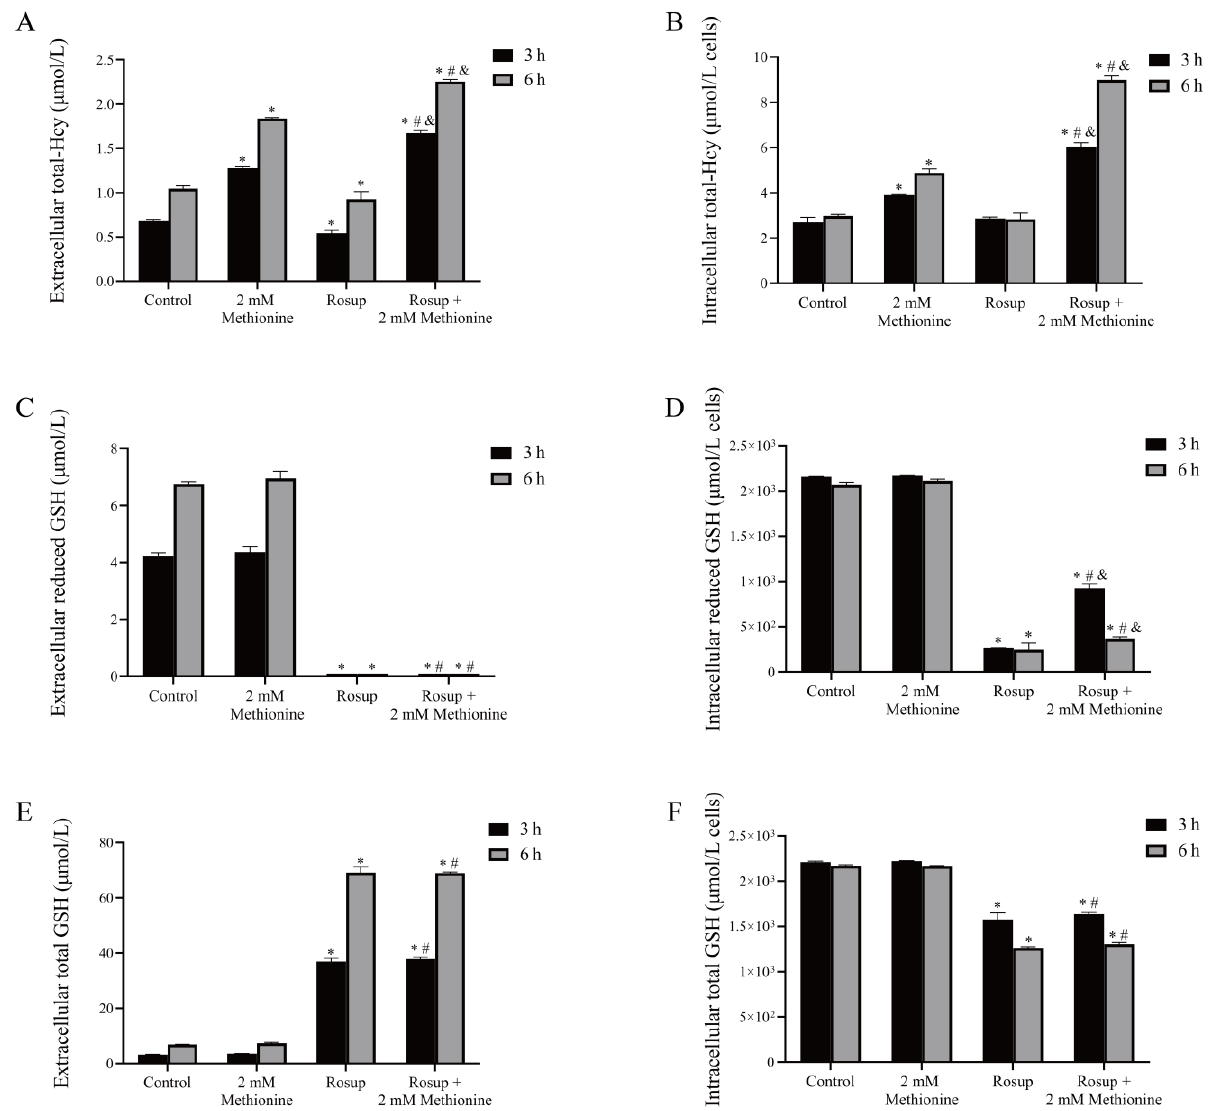
Figure 6. The alterations of total-Hcy and GSH levels in erythrocytes after treatment with Rosup in the presence or absence of methionine ( n = 3). ( A ) The concentration of extracellular total-Hcy reduced slightly after Rosup treatment, compared with that of control. Methionine (2 mM) plus Rosup treatment for 3 h or 6 h resulted in a significant increase of extracellular total-Hcy contents, compared with 2 mM methionine or Rosup treatment alone ( p < 0.05). ( B ) Intracellular total-Hcy level did not alter significantly after Rosup treatment ( p > 0.05). Methionine (2 mM) plus Rosup treatment for 3 h or 6 h caused a significant increase of intracellular total-Hcy contents, compared with 2